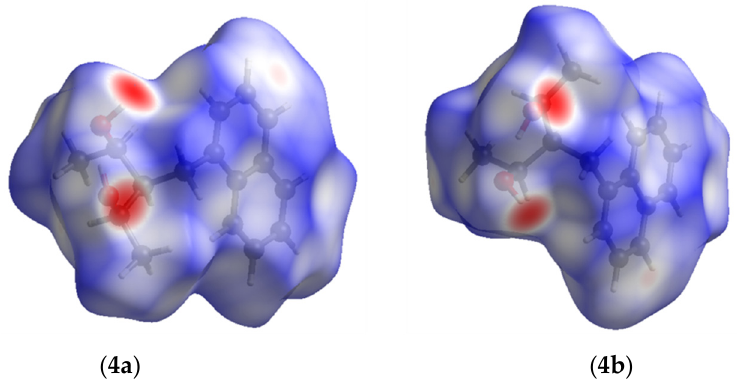
Figure 4. Hirshfeld surface of compounds 4a and 4b . Table 4. Two-dimensional fingerprint plots of compounds 4a and 4b .